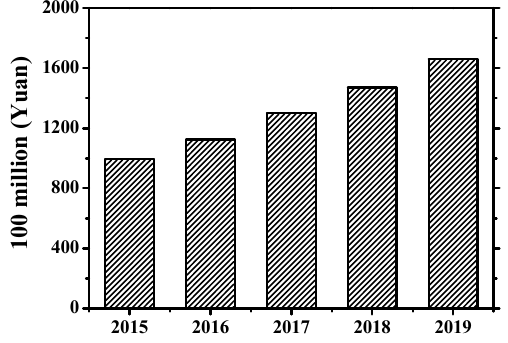
Figure 12. The development of the sensor market in China.